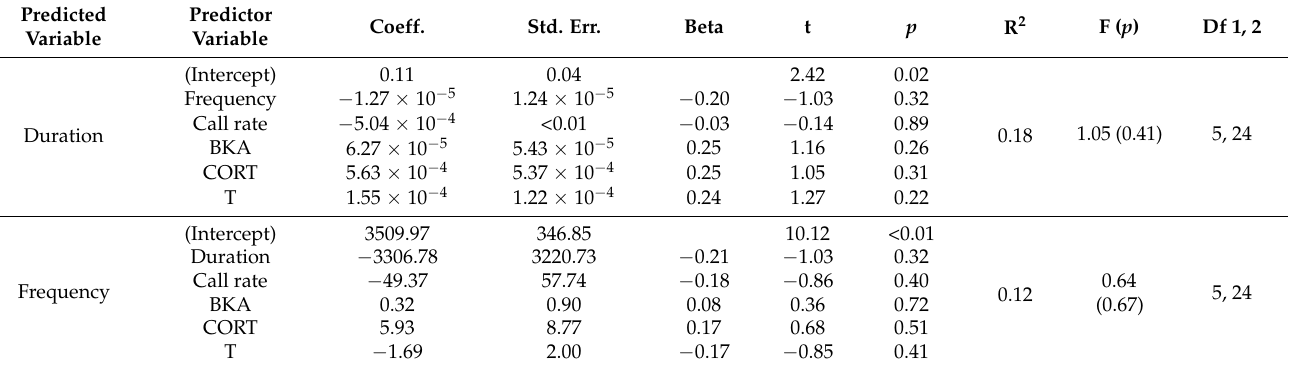
Table A1. Analysis of factors affecting behavioral (note duration, dominant frequency, and call rate); physiological (corticosterone, CORT and testosterone, T); and immunological (bacterial killing ability, BKA) factors determined using multiple linear regression analysis. The gray box represents significant correlations ( p < 0.05) between two